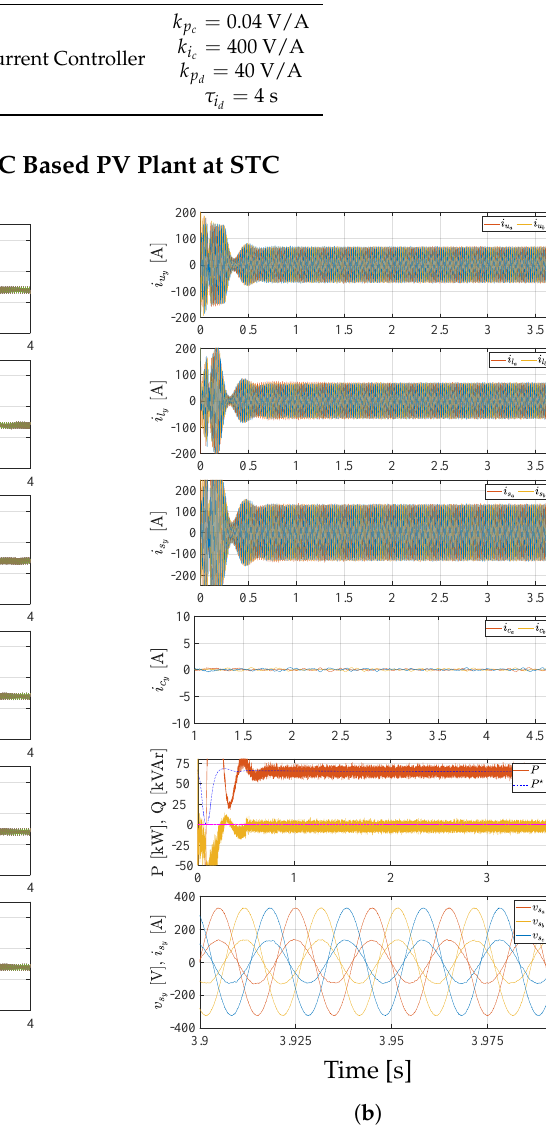
Figure A1. Simulation results for scenario 1 ( a ) Capacitor voltages for all the sub-modules in an arm of the MMC for all three phases. From the top, upper arm phase “a”, upper arm phase “b”, upper arm phase “c”, lower arm phase “a”, lower arm phase “b”, and lower arm phase “c”, respectively. [ A ] , i l [ A ] ), output currents ( i s [ A ] ), circulating currents ( b ) The upper and lower arm currents ( i u y y y [ A ] ( i c y = a, b, c), the active and reactive power injected to the grid ( P [ kW ] , Q [ kVAr ] ) and the plot y ∀ [ V ] [ A ] ) for 100 ms duration shown the voltages ( v s y = a, b, c) at PCC and the phase currents ( i s y y ∀ between 4.9 s to 5 s, y = a, b, ∀